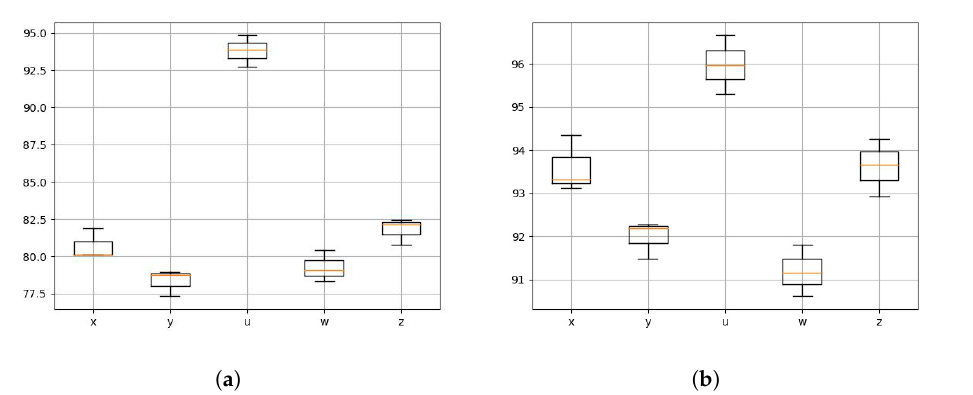
Figure 10. Accuracy of motion recognition in different positions. ( a ) Using CSI data. ( b ) Using human velocity distribution.